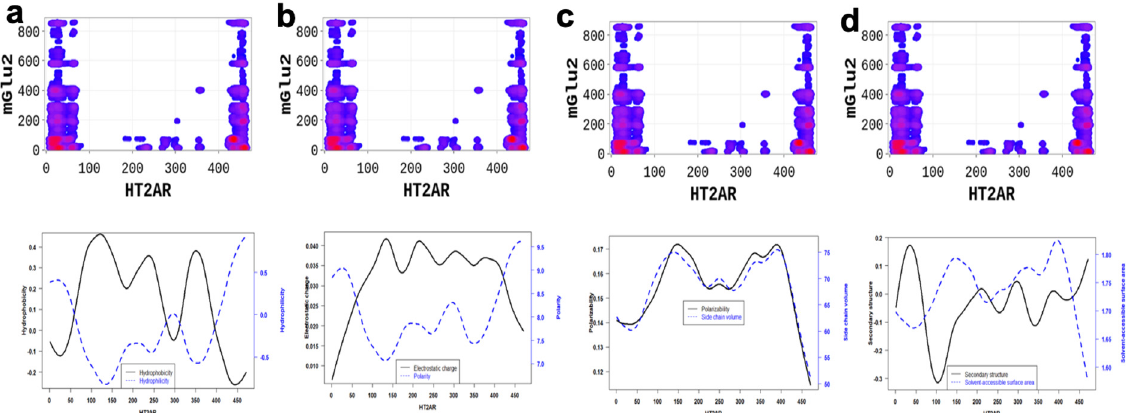
Figure 6. 5-HT2AR/mGlu2R dimerization is mainly driven by ( a ) the hydrophilicity, ( b ) the electrostatic charge and polarity, ( c ) the polarizability and side chain, and ( d ) the secondary structure similarity and solvent accessibility properties of the 5-HT2AR amino-acids located at the interfaces. On average, polarity and hydrophilicity properties of amino-acids are higher, however secondary structure, electrostatic charge, polarizability, side chain volume, and solvent-accessible surface area property are lower at the predicted hot-spots and their secondary structures are dominated by alpha-helix conformation.